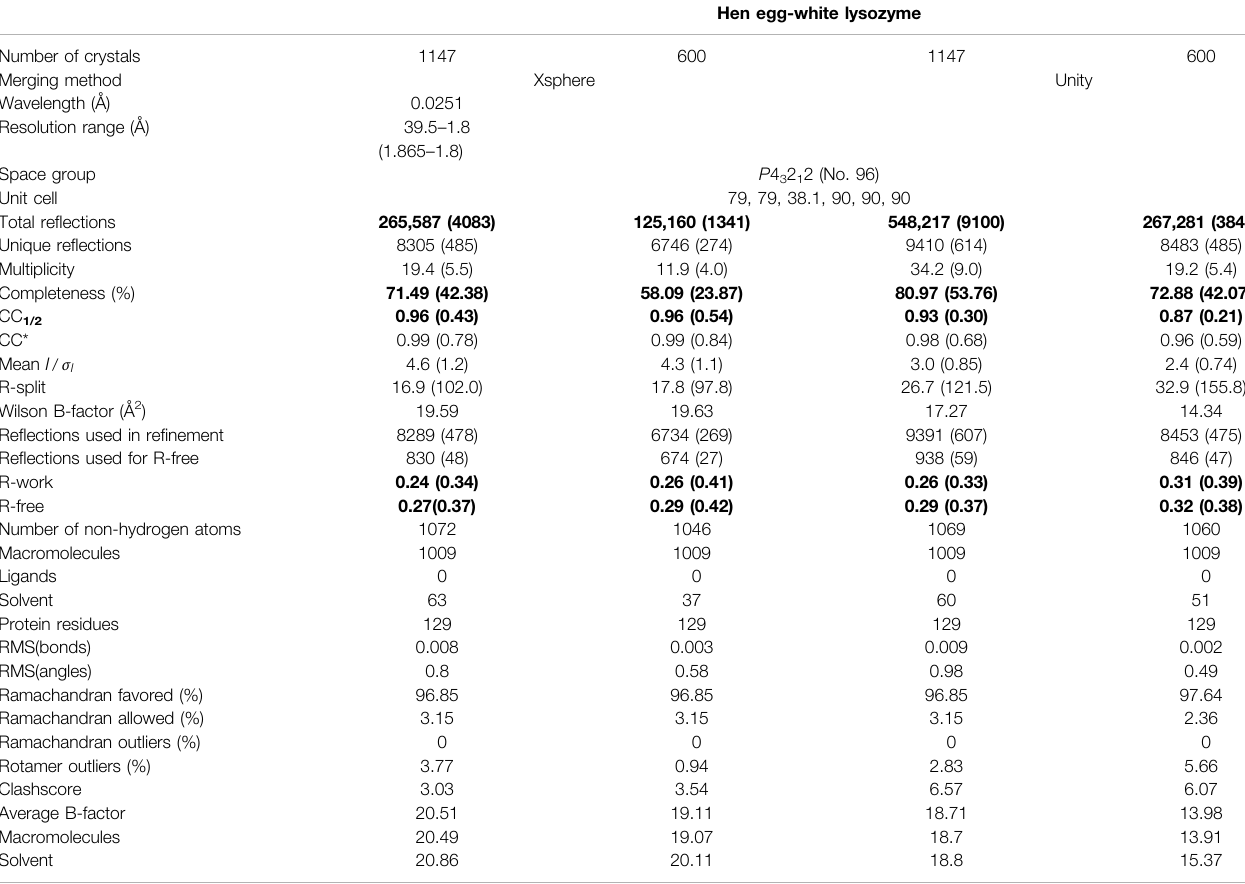
TABLE 1| Merging andre fi nement statistics forfourrepresentative processing runs, allderived fromthesame dataset asdiscussed inthetext. Foreach ofthetwomerging strategies xsphere (partiality modeling) and unity (Monte-Carlo averaging) data are shown for the fulldataset (1147 crystals) and a sub-set of approximately half that size (600 crystals). Quantities discussed in the main text are printed in bold